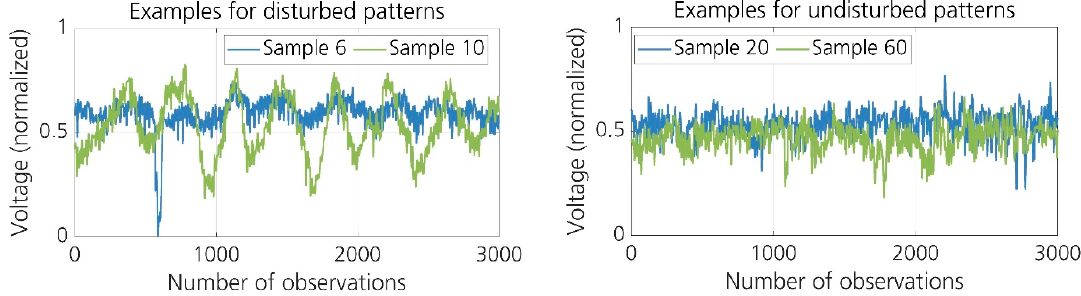
Figure 16. Outlier samples ( left ) and non-outlier samples ( right ).